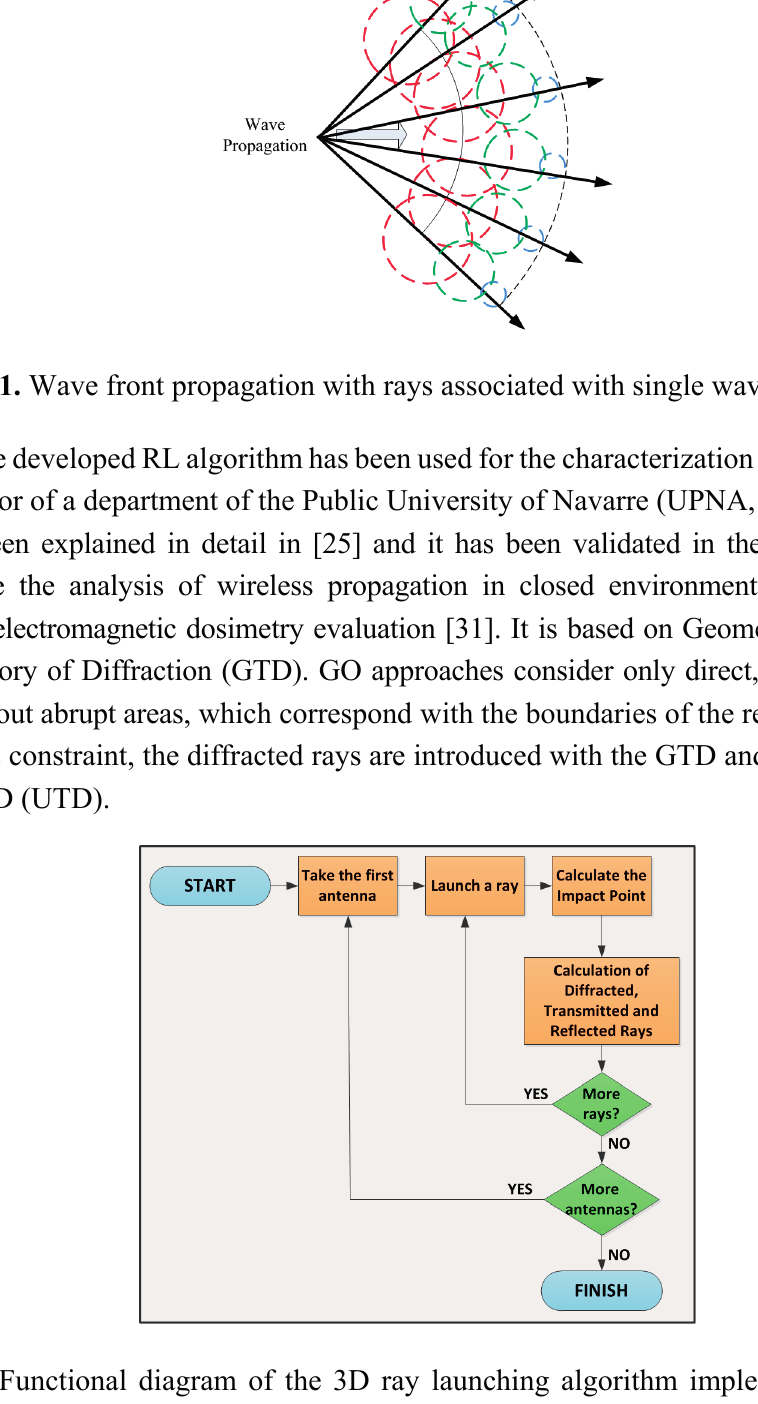
Figure 2. Functional diagram of the 3D ray launching algorithm implemented at Public University of